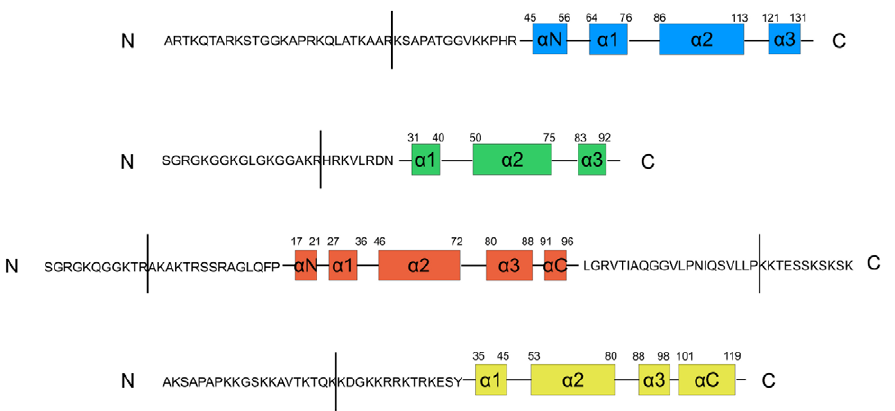
Figure 2. Tail domains of the core histone proteins with positions where they were clipped indicated by lines. In the tail-truncated nucleosome simulations the N-terminal tail domains of H3, H4, H2A and H2B were removed up to residues 26, 17, 11 and 20, respectively. For the H2A tail-truncated simulation the C-terminal residues 118–128 were also removed. Truncation sites for each tail were chosen at known trypsin cleavage sites [44].